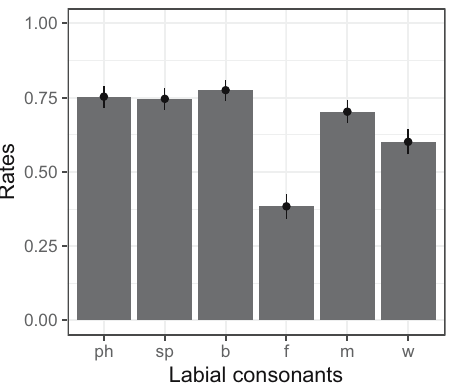
Figure 3: Rates of selecting names with labial consonants for a “ soft ” name ( English ) .